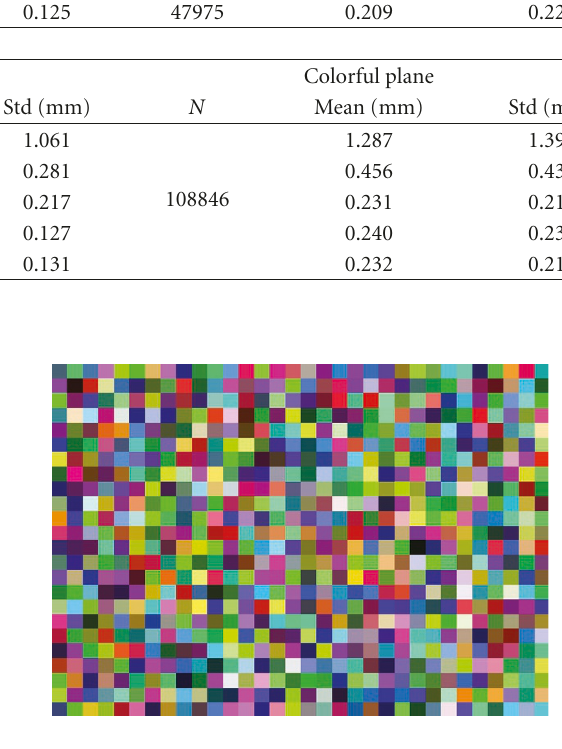
Figure 3: Evaluation method for colorful surfaces. The figure shows a randomly generated colorful pattern which is printed and stuck on the measuring